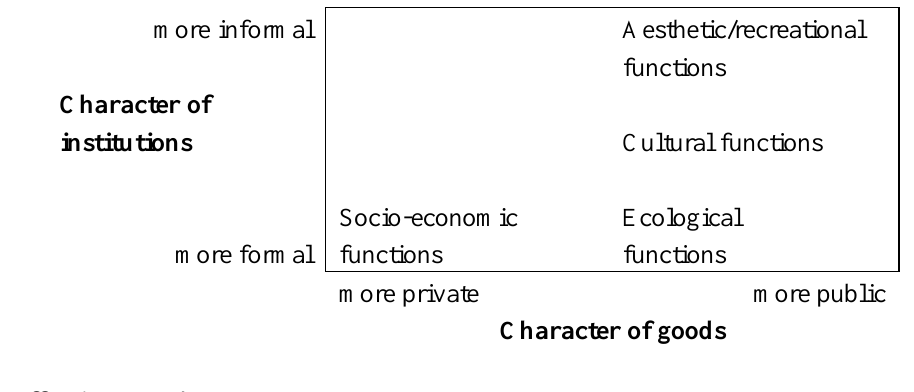
Table 2. Character of institutions guiding different functions of forests. Adapted from